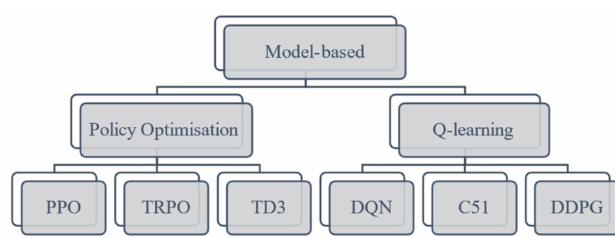
Figure 3. Model-free reinforcement learning algorithms.